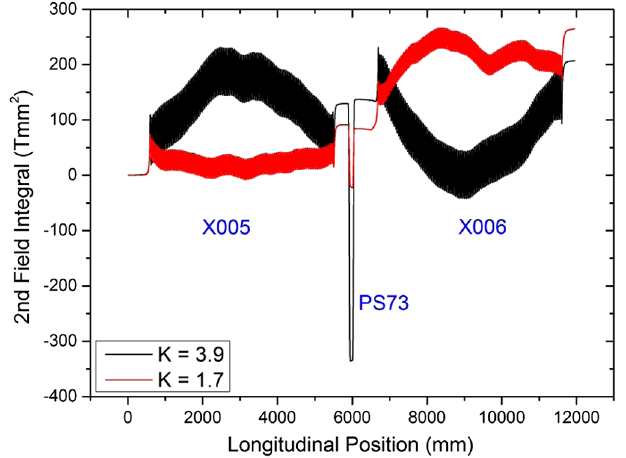
FIG. 12. Second field integrals of the two undulators U40- X005 and U40-X006 in combination with the phase shifter PS073. Black K ¼ 3 . 9 ; red K ¼ 1 . 7 .